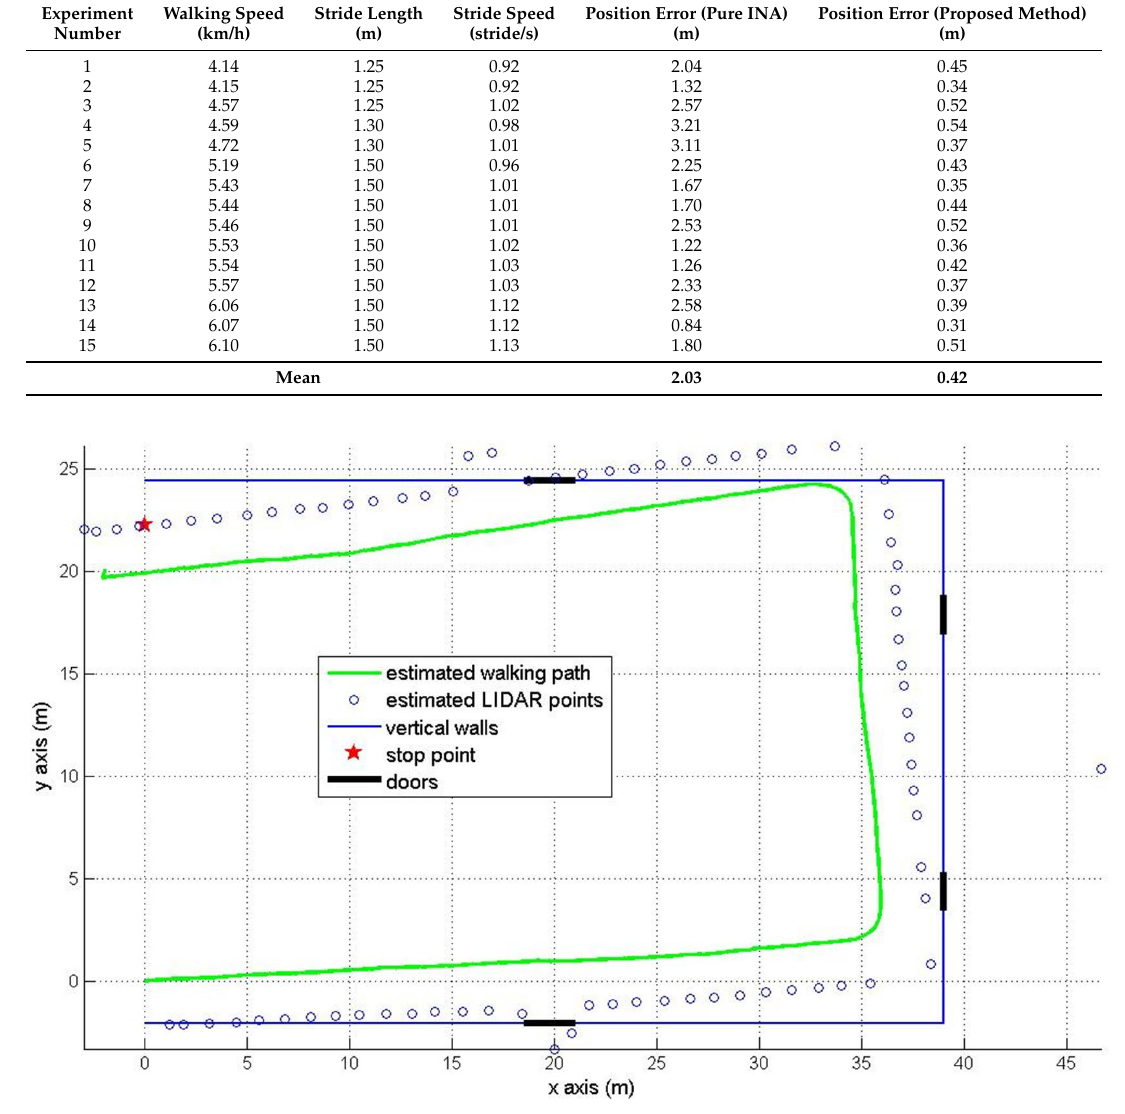
Table 2. Final position error comparison in the corridor walking with different walking style.